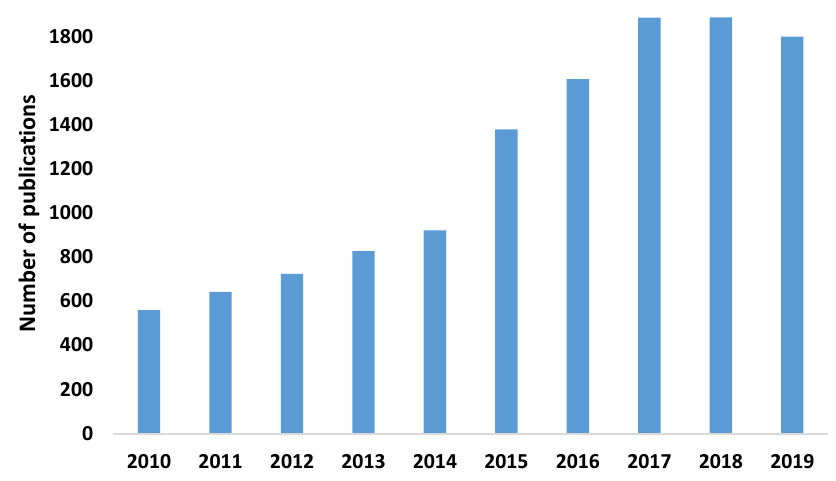
Figure 1. Number of publications per year.